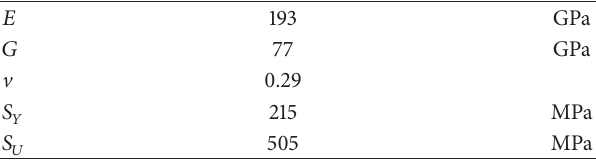
Table 3: Material properties of AISI 304 stainless